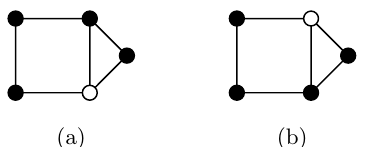
Figure 2: Two automorphic states of the ESPD on the underlying graph in Figure 1(a), where a solid vertex represents a cooperator, while an open vertex represents a defector.